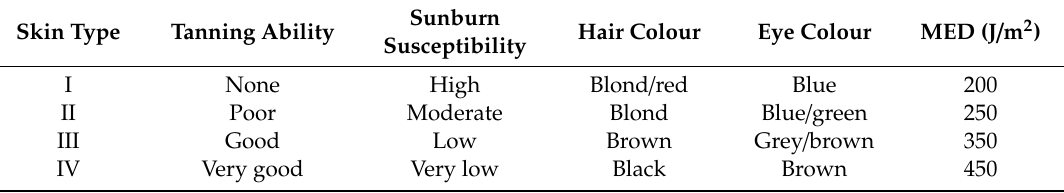
Table 2. Skin types by ISO 17166 CIES S 007 /